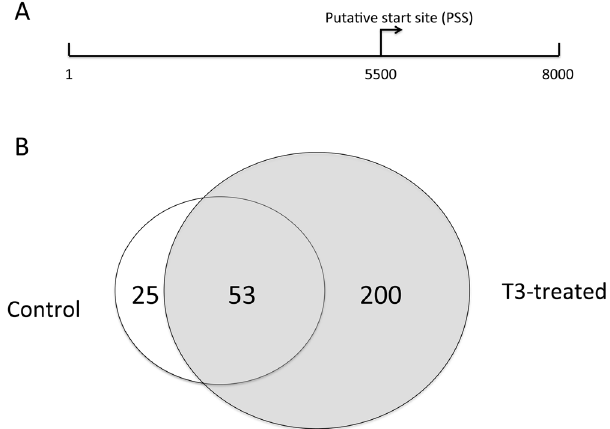
Figure 1. ChIP-on-chip assay identified putative TR targets in the tadpole intestine. ( A ) Schematic representation of a gene in the genomic chips. About 5500 bp upstream and 2500 bp downstream of the 5 ′ -end of the cDNA sequence in the databank for each putative gene in the Xenopus tropicalis genome database were used to design a 60 bp oligonucleotide probe at an average tiling distance of 205 bp, covering the entire 8000 bp. The probes were custom-printed onto the genomic chips. PSS: putative transcription start site. ( B ) Venn- diagram showing the genes with TR binding sites as identified from the ChIP-on-chip assay with the intestine samples from control and T3-treated stage 54 premetamorphic tadpoles. Note that vast majority of the genes bound by TR in the control tadpoles were also found in the T3-treated animals.